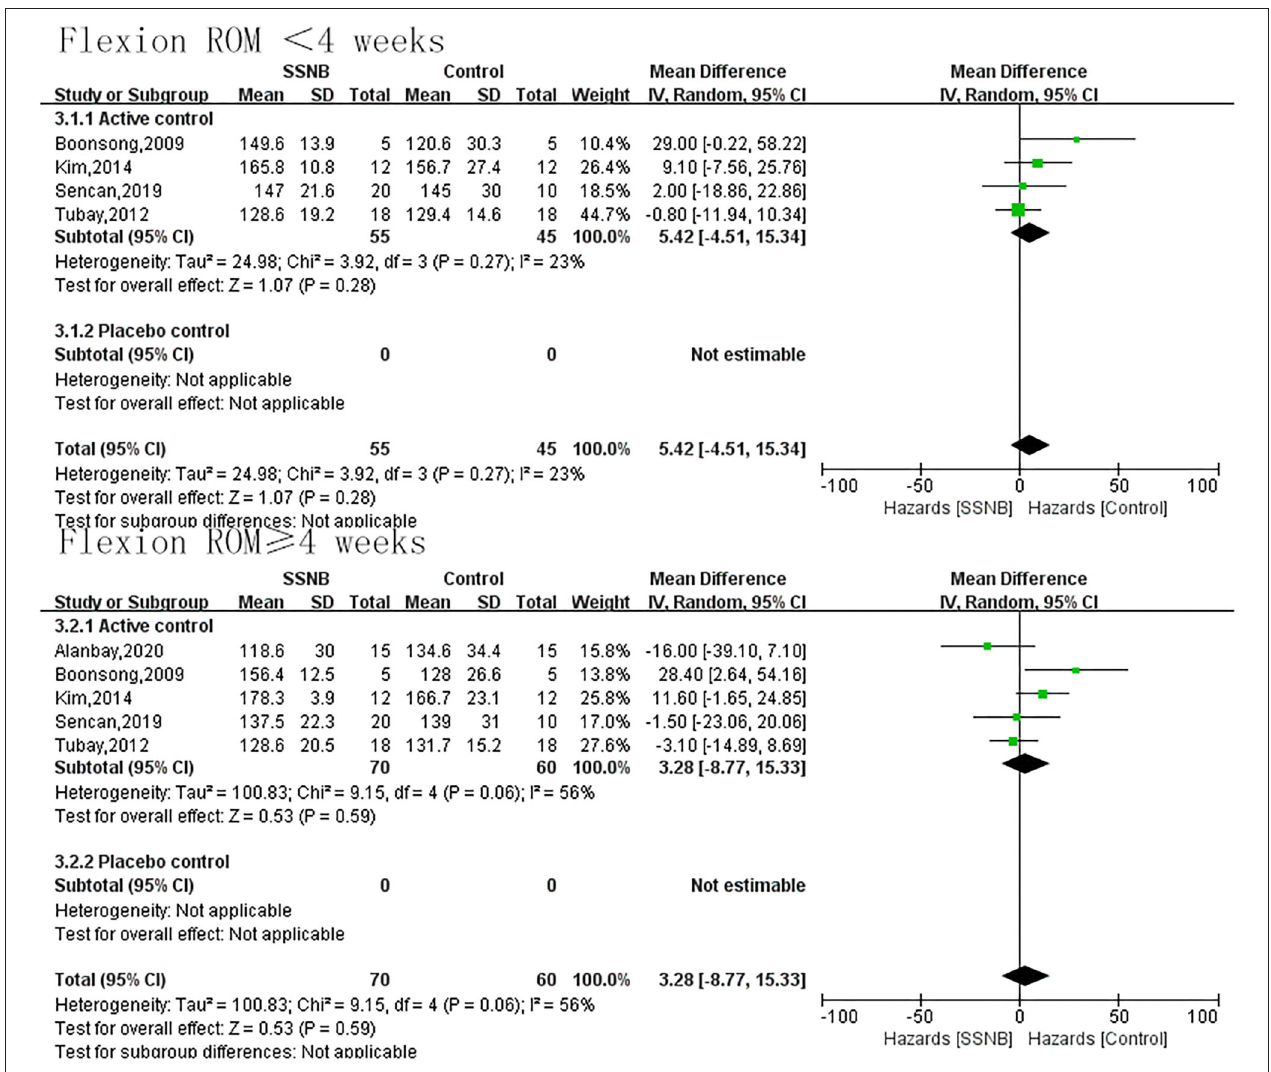
FIGURE 4 | Forest plot of flexion ROM between SSNB and other